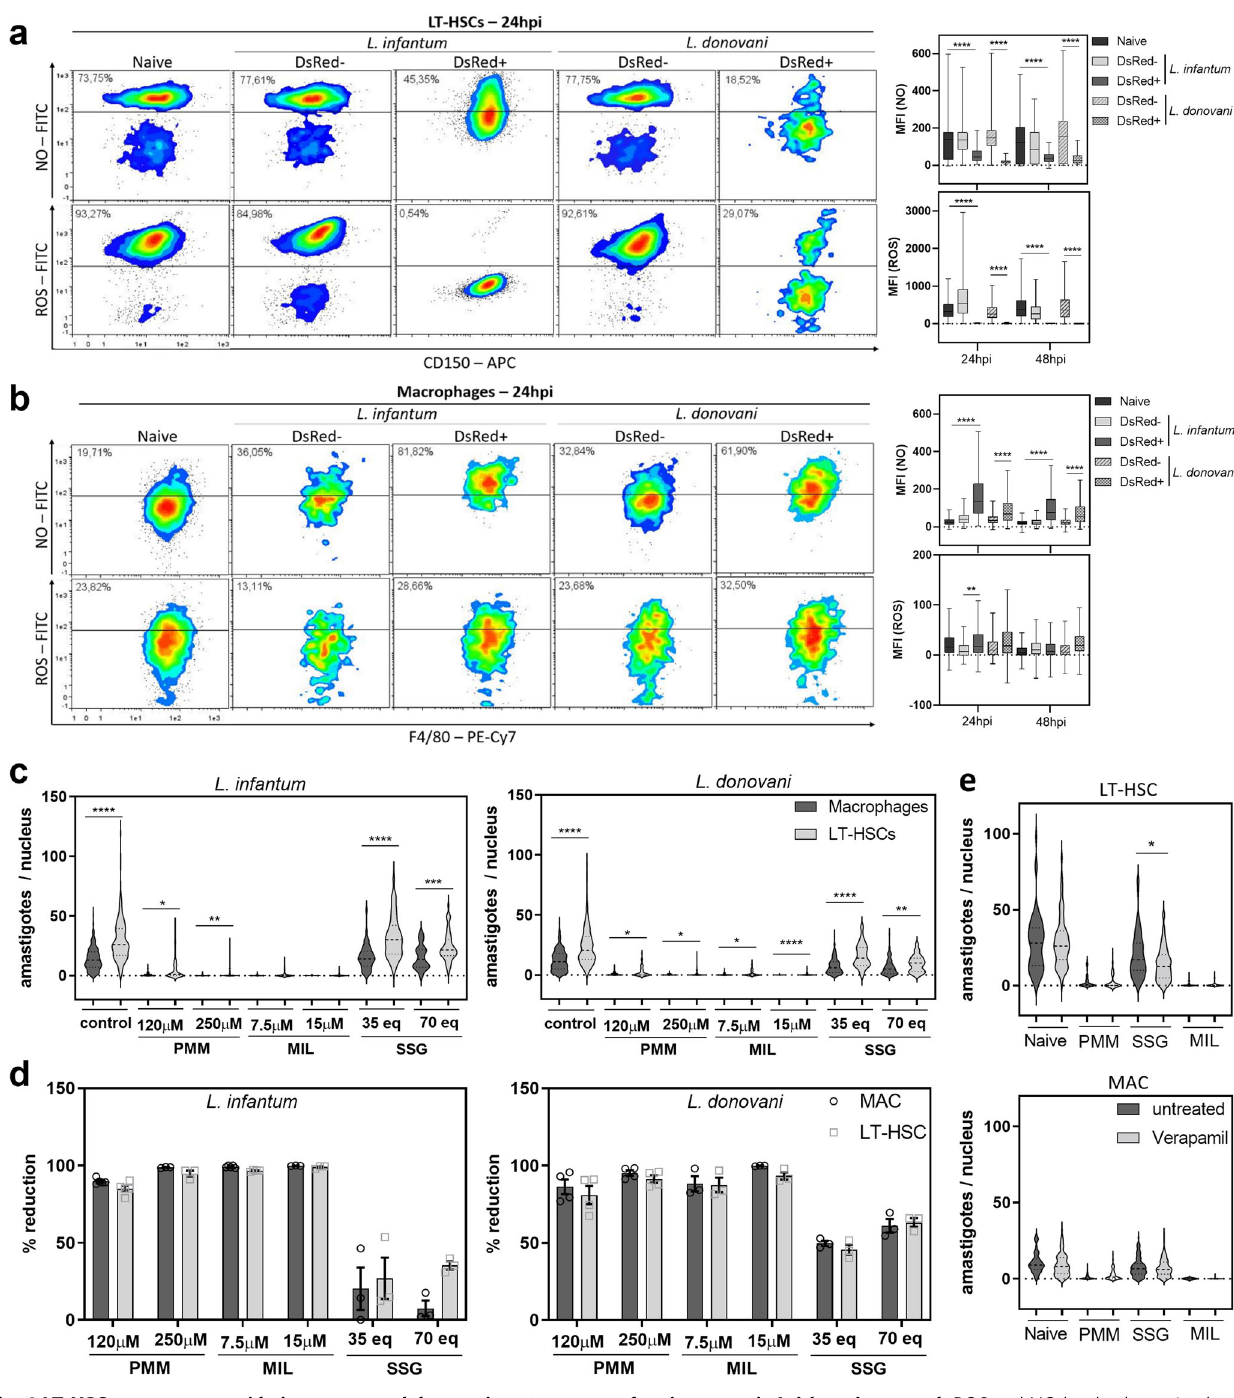
Fig. 4 LT-HSC represent an oxidative stress- and drug-resistant sanctuary for viscerotropic Leishmania spp. a , b ROS and NO levels, determined using CM-H 2 DCFDA and DAF-FM diacetate, are decreased in ex vivo infected stem cells. Density plots of LT-HSC ( a ) and macrophages ( b ) at 24h post-infection (hpi) with fl uorescent signal of NO (top rows) and ROS (bottom rows). Graph represents the MFI of these plots at 24 and 48h post-infection. Representative dot plots with corresponding graphs of three independent experiments with similar results are shown. Multiple t tests (two-tailed) after outlier analysis (ROUT, Q = 1%), boxplots represent minimum, maximum, median and 75% and 25% percentiles, 155 ≤ n ≤ 16250, ** p <0.01, **** p <0.0001. c Sorted LT-HSC infected with L. donovani L82 WT PpyRE9/DsRed in a 5:1 ratio and treated for 120h. Representative plots of two independent experiments for PMM (120 and 250 µ M), MIL (7.5 and 15 µ M), and SSG (35 eq. Sb and 70 eq. Sb) are shown. Con fi rmatory results with PMM, MIL, and SSG on L. infantum LEM3323 (with inherent Sb resistance) in two independent experiments. Results are expressed as mean±SEM. Mann-Whitney test, 45 ≤ n ≤ 250, * p <0.05, ** p <0.01, **** p <0.0001. d Percentage of reduction compared to untreated controls is shown, calculated from the data shown in ( c ). e Effect of 120h co-incubation of verapamil (8 µ M) with PMM (120 µ M), MIL (7.5 µ M), and SSG (35 eq. Sb) on L. infantum LEM3323 WT PpyRE9/DsRed (with inherent Sb resistance) infected (5:1) sorted LT-HSC and BM-derived macrophages. Results are based on three independent experiments. Mann – Whitney test, 60 ≤ n ≤ 100, * p